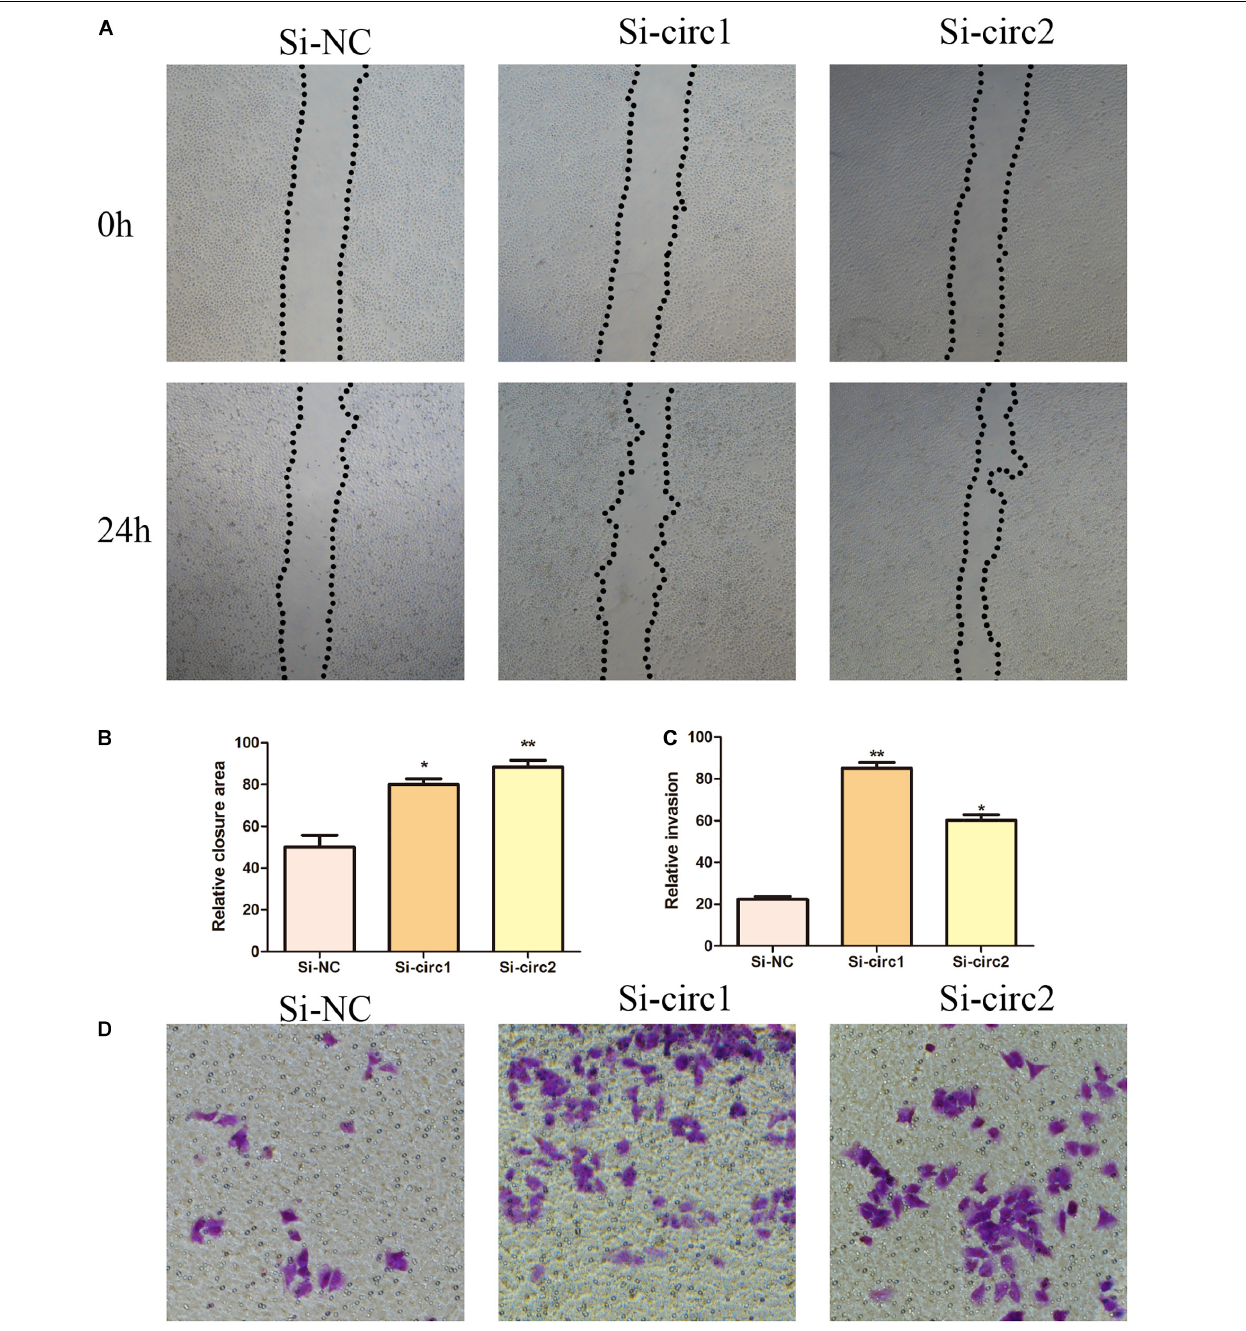
FIGURE 3 | Effects of hsa_circ_0004543 knockdown on invasion and migration of HUVECs induced by oxLDL. (A,B) The migratory activity was detected at 0 and 24 h (black dotted line) by the wound-healing assay. (C,D) Cell invasion was evaluated by the Transwell assay ( × 100). * p < 0.05, ** p < 0.01.